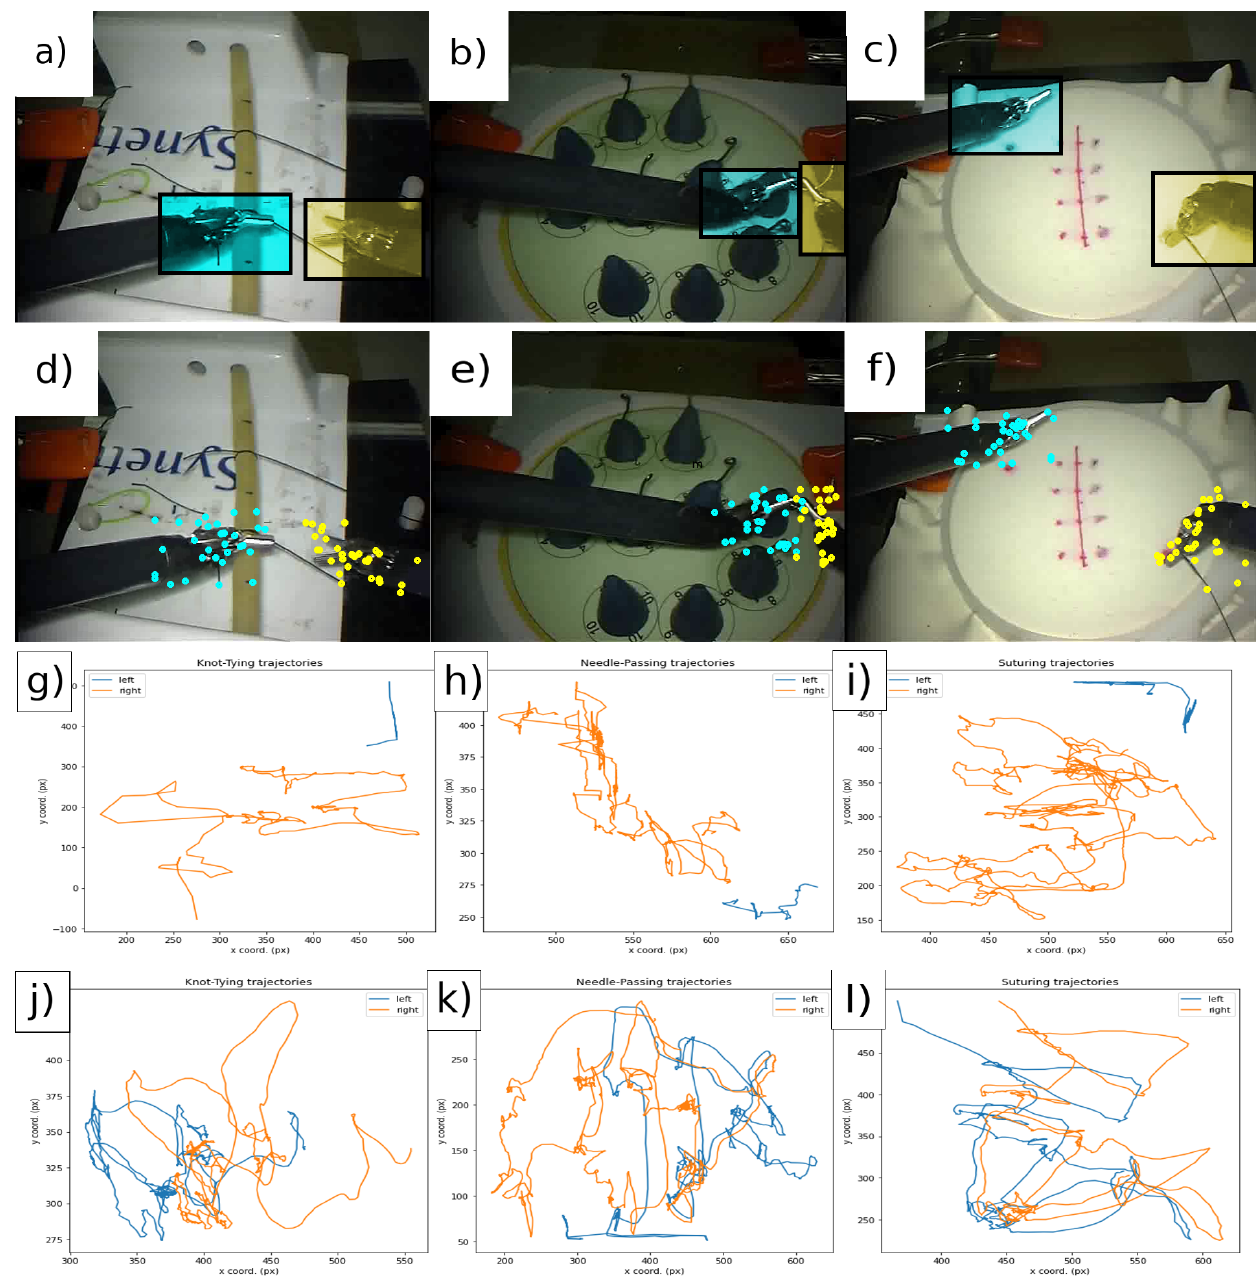
Figure 2. The three surgical tasks in the JIGSAWS database: Knot-Tying (KT), Needle-Passing (NP) and Suturing (ST). ( a – c ) The selection of Regions Of Interest (ROIs). ( d – f ) The initial samples computed by the Shi–Tomasi method. The third and fourth rows show one tracked points’ trajectory from each tool (blue, left; orange, right). ( g – i ) The data are from a novice user. ( j – l ) The data are from an expert